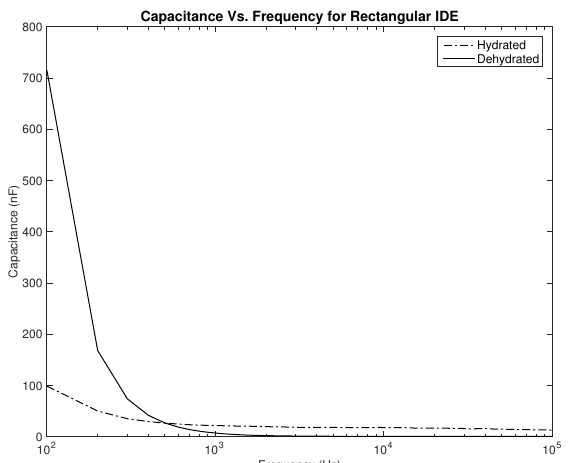
Figure 7. Simulation results—resistance ( Ω ) of hydrated and dehydrated skin using the circular IDE design.